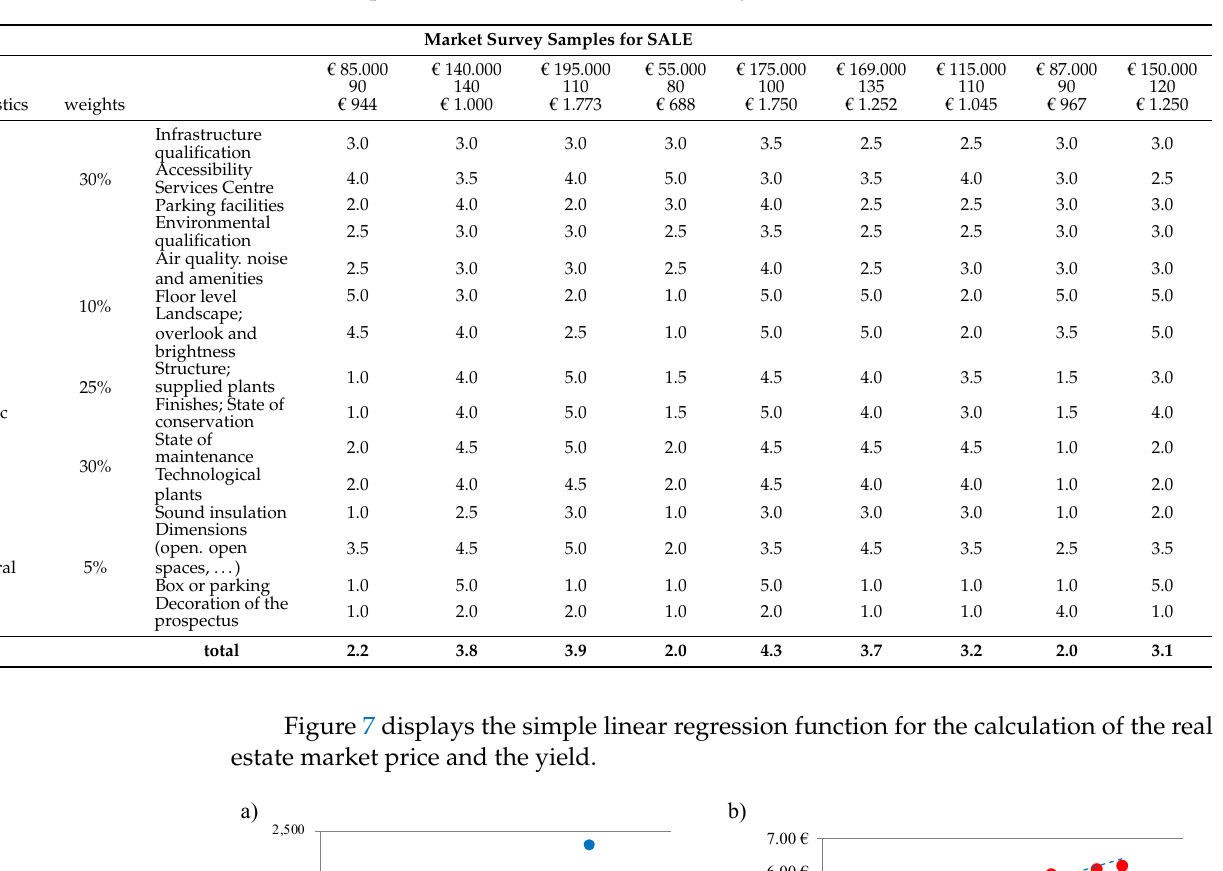
Table 3. Excerpt of the real estate market rent survey.